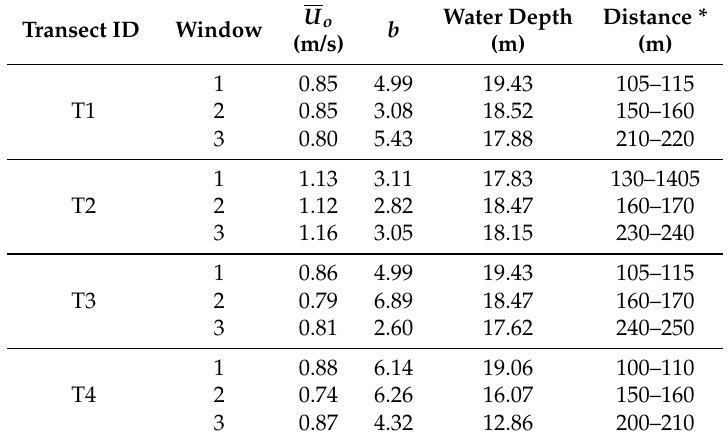
Table 2. Average values of U o , b , water depth and distance from the shelf edge for each 10-m window. U o Water b Transect ID Window